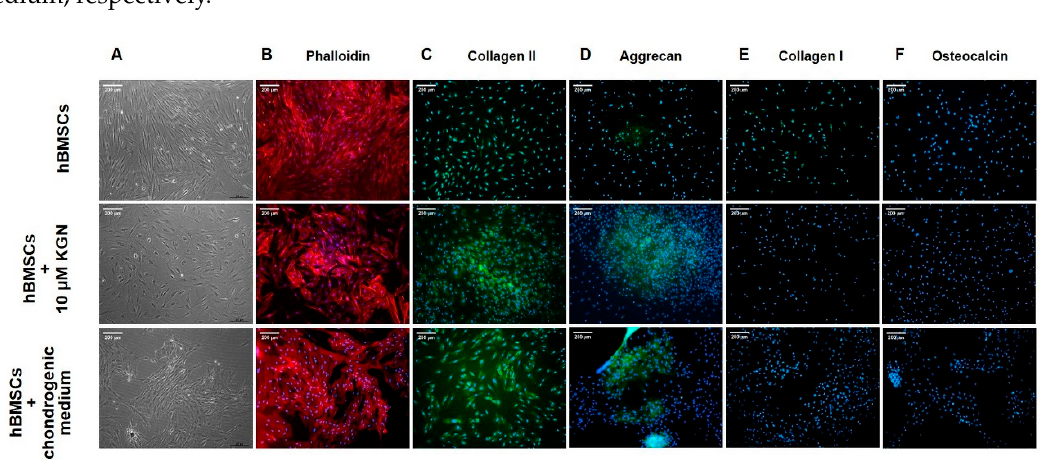
Figure 2. The effect of KGN on hMBSCs morphology and expression profile. Cell morphology and cytoskeleton of hBMSCs in monolayer culture during chondrogenic differentiation at day 21. Representative images of ( A ) phase contrast microscopy and ( B ) fluorescently-stained actin cytoskeleton of primary cultures of hBMSCs at passage 2. Effect of KGN on cartilage-specific and nonspecific markers detected by immunofluorescence in monolayer cultures of hBMSCs at day 21. ( C ) Cells were stained for collagen II (green); ( D ) cells were stained for aggrecan (green); ( E ) cells were stained for collagen I (green); and ( F ) cells were stained for osteocalcin (green). Cell nuclei were counterstained with DAPI (blue). Scale bar represents 200 µm.